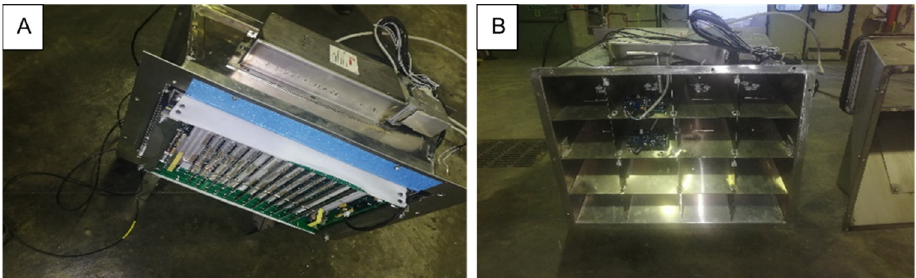
Figure 1. Front view ( A ) and sub-ducts posterior view ( B ) of CSA system.